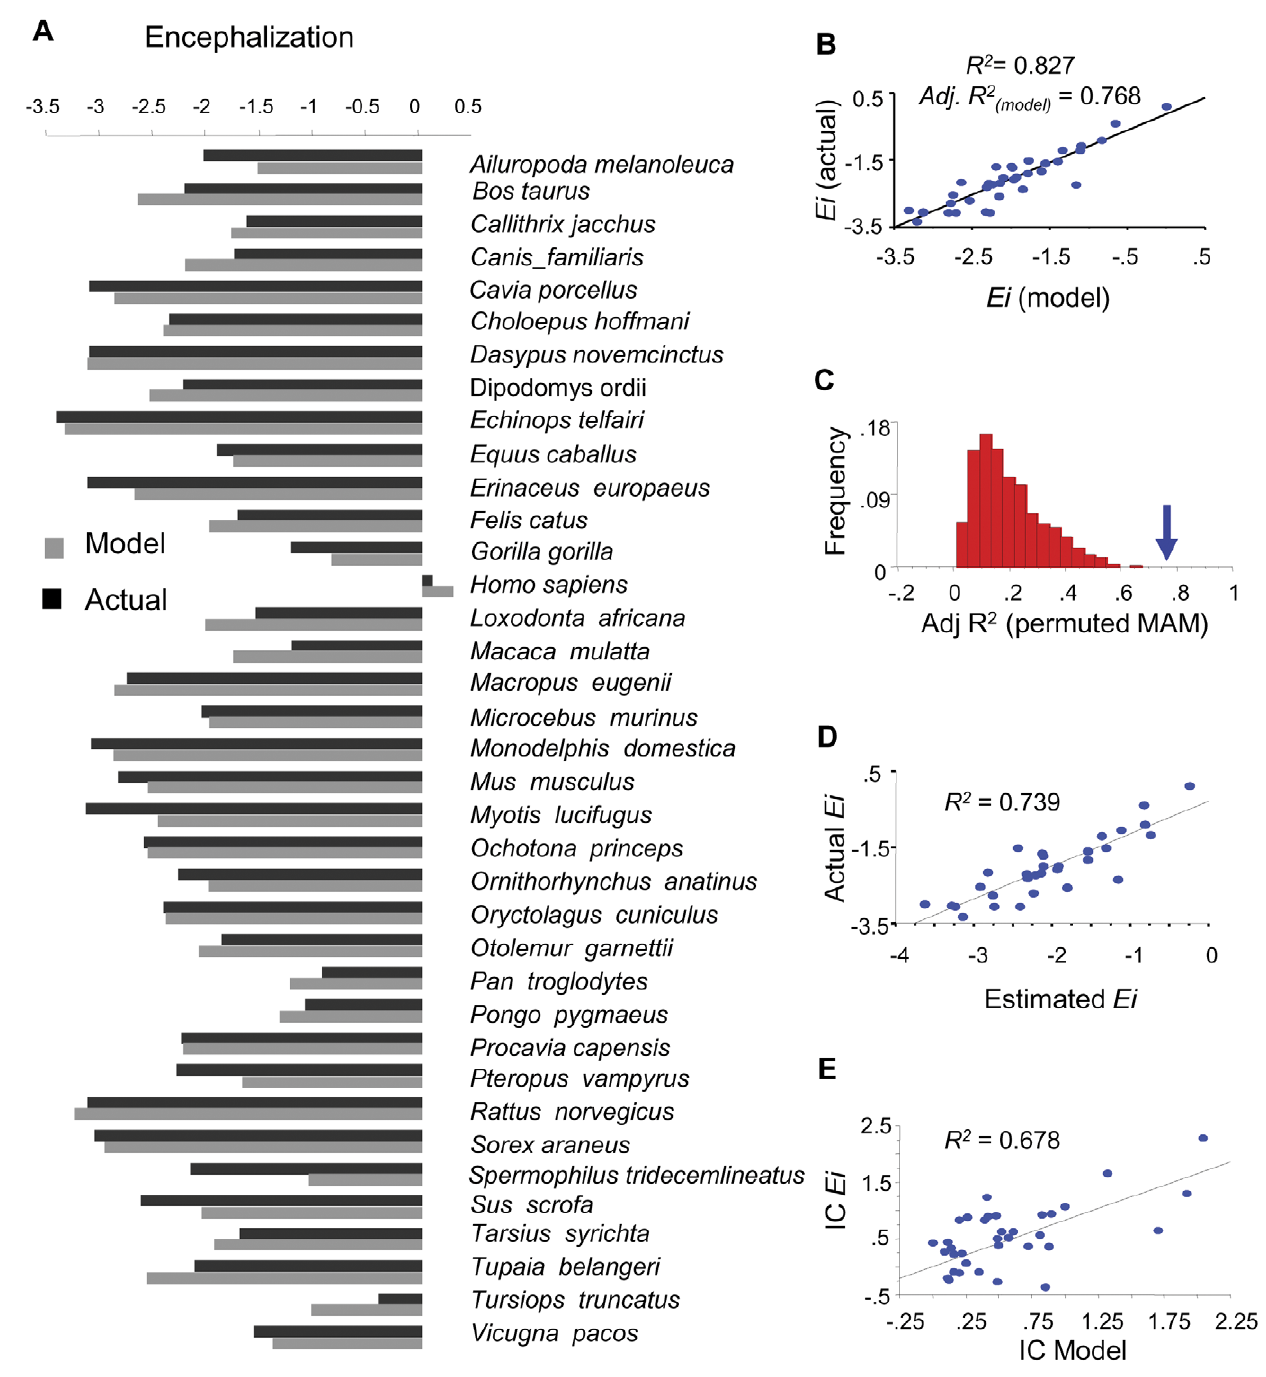
Figure 2. Performance of optimal multiple regression model predicting encephalization. The minimum adequate model (MAM) with the highest F statistics was exhaustively searched for within the corresponding space of 2 20 possible models (see Table 1). A) Bar chart showing comparisons between actual Ei values per species (black bars) and the values derived from the corresponding optimal model based on AA composition (grey bars). B) Graph showing in-sample goodness of fit between actual and AA -based estimates of Ei values. R 2 , and Adj.R 2 values are shown . C) Distribution of Adj.R 2 values corresponding to control MAMs obtained for 1000 independent permutations of Ei Values. The blue arrow indicates the value of the actual model in panel B ( P , 0.001). D) Over-fitting control analysis showing the performance of the optimal linear model predicting encephalization. All species were randomly sorted into nine groups and the Ei values of each group were predicted using coefficients derived de novo from the remaining out-of- group species. The graph shows the relationship between the actual and predicted values with the corresponding R 2 and associated P value shown. E) Independent contrast analysis, which controls for phylogenetic effects, was carried out between Ei , and the AA usage-based estimates of Ei . The relevant phylogeny for all 37 species was obtained from Ensembl genome data resource and standardized contrasts (IC) were generated using the PDAP: PD TREE module in the Mesquite environment. ( R 2 =0.678, through the origin, P , 0.0001).